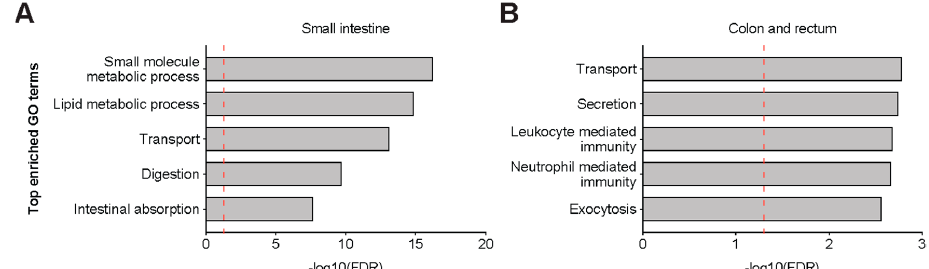
Figure 3. Co-expression of ACE2 and TMPRSS2 with TMPRSS4 . ( A ) UMAP plots depicting cells that co-express ACE2 , TMPRSS2 , and TMPRSS4 in small intestine and colon/rectum. ( B ) Bar plots depicting proportions of cell types in the small intestine and colon/rectum that co-express ACE2 , TMPRSS2 , and TMPRSS4 .